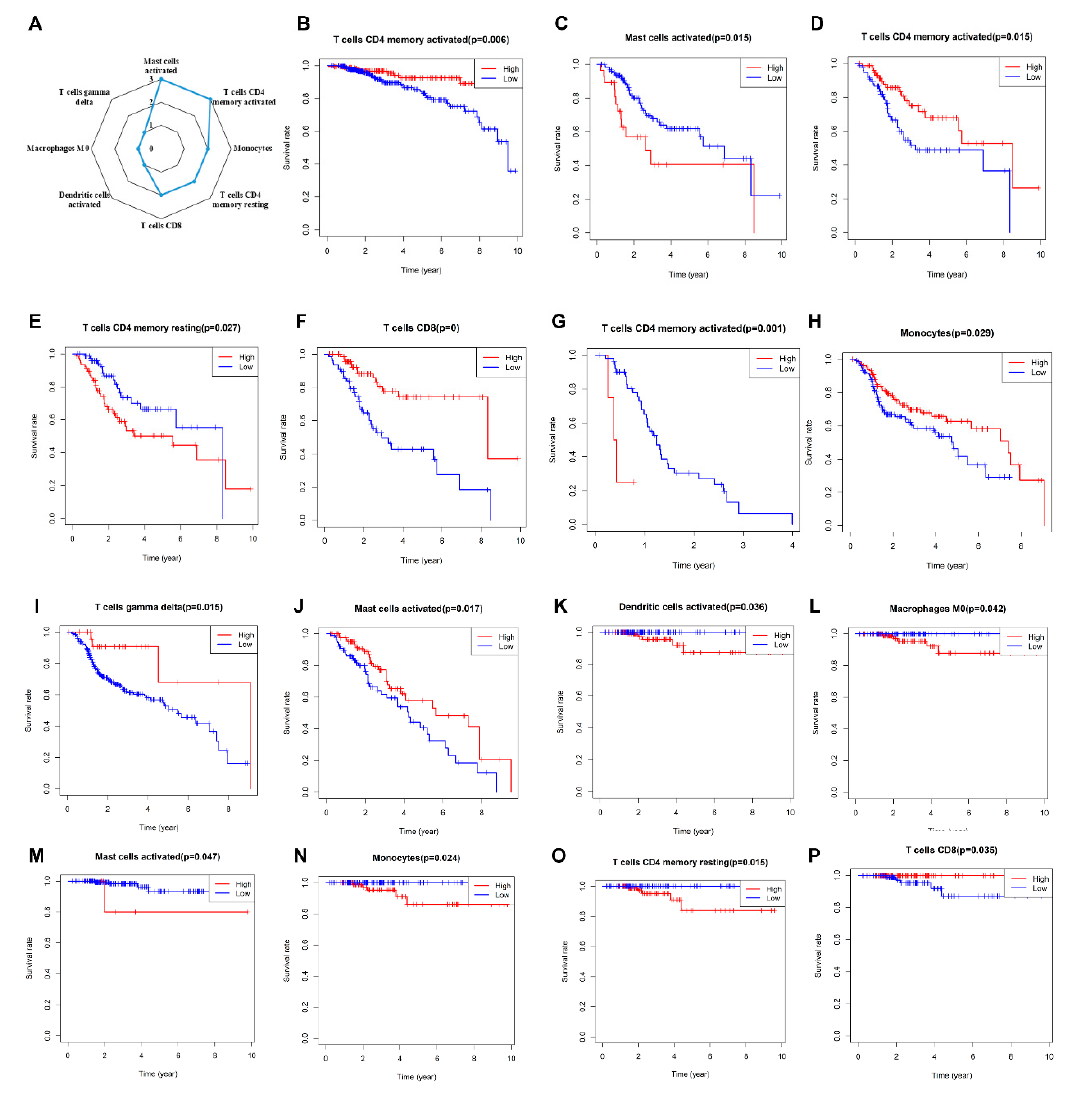
Figure 4. Prognostic value of 22 tumors infiltrating immune cells across seven cancer types. The radar chart ( A ) gives an overview of the cell types with prognostic value. According to the Kaplan–Meier analysis, only cells that displayed significant correlation RT outcomes were shown in this figure ( B - P ). Red lines indicate high immune infiltration of a certain cell, and blue lines indicate low immune infiltration. Each picture corresponds to a different type of cancer BRCA ( B ), CESC ( C - F ), GBM( G ), HNSC ( H , I), LGG ( J ), THCA ( K - P